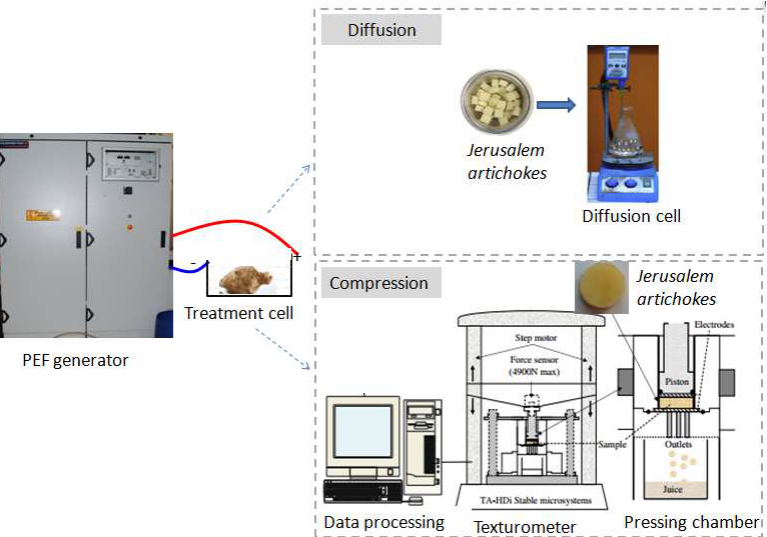
Figure 1. Set-up used for pulsed electric fields (PEF) treatment, texture analysis, and diffusion.